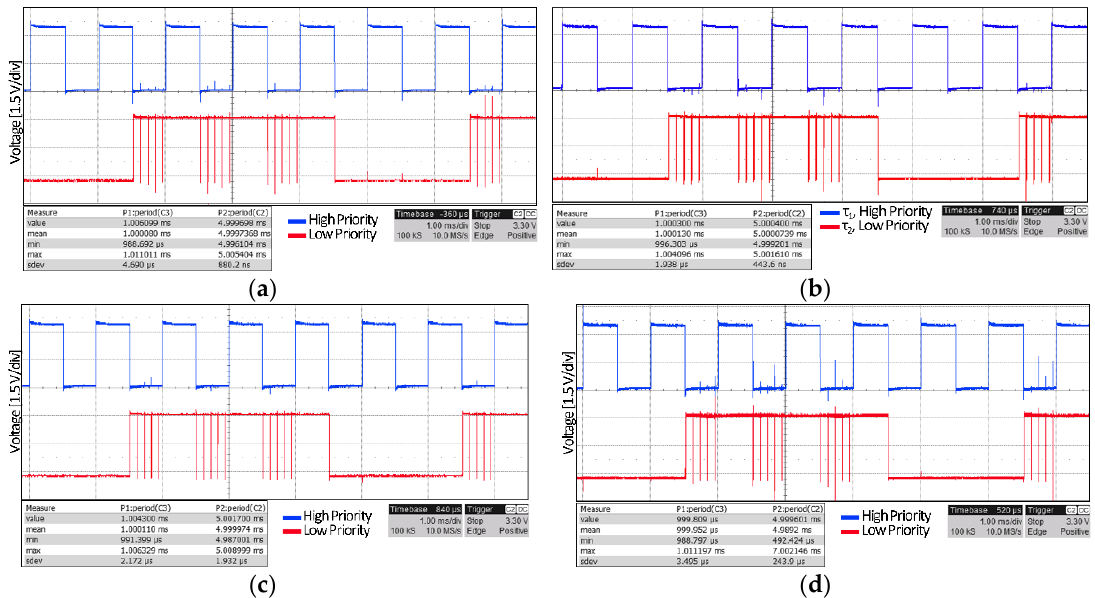
Figure 7. Periodicity of the real-time tasks with a real-time device driver: ( a ) BeagleBone Black; ( b ) Raspberry Pi 3 ( c ) Zybo-7020; ( d ) i.MX6Q SABRELite.